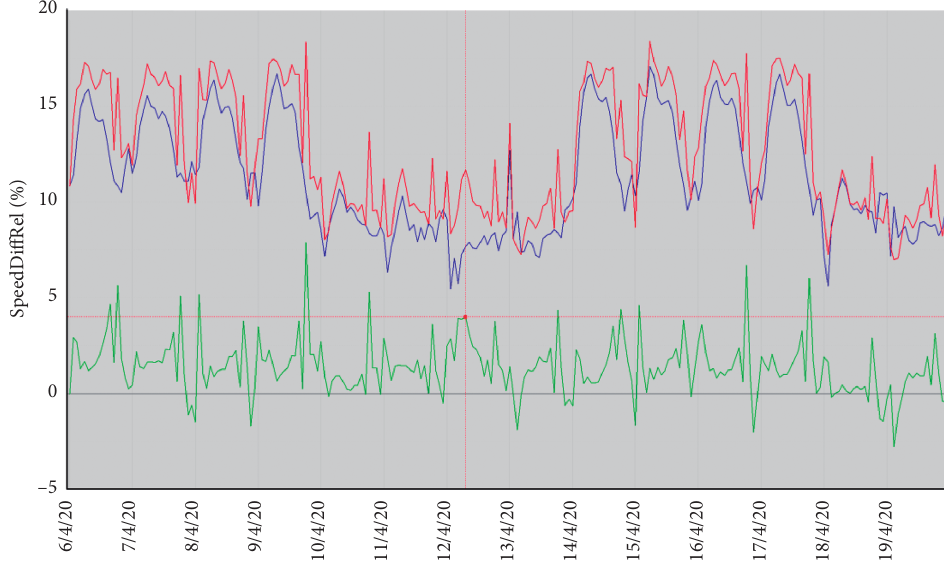
Figure 11: Period around Easter from 6 April 2020 to 19 April 2020. SpeedDiffRel in percentage points by